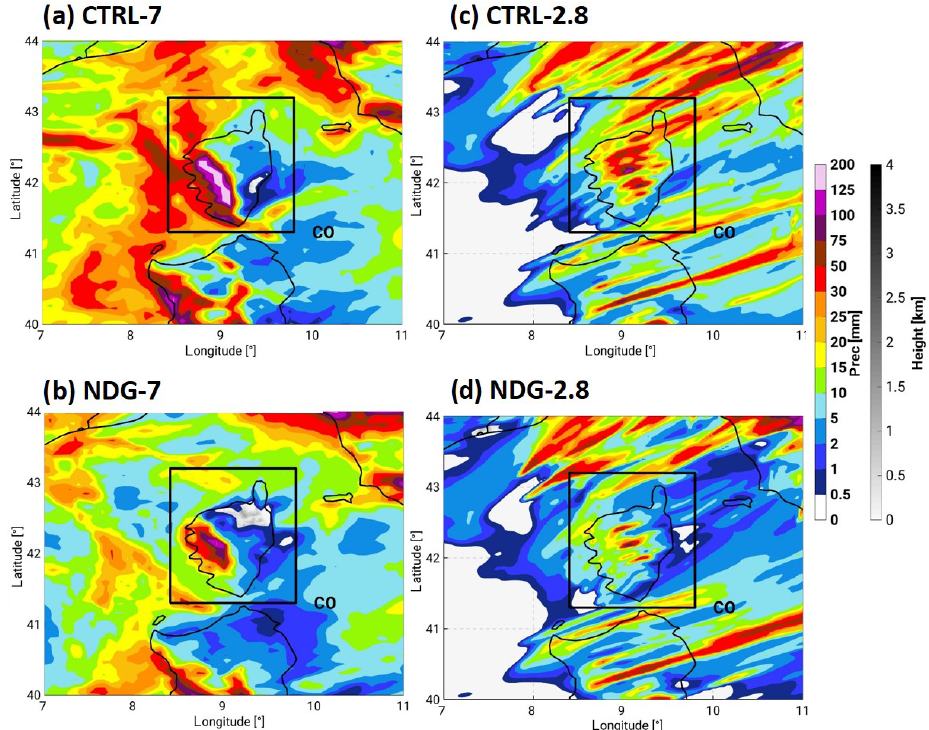
Figure 8. COSMO-CLM-accumulated precipitation over Corsica between 26 October at 13:00UTC and 27 October at 15:00UTC, i.e. during the period of precipitation over the